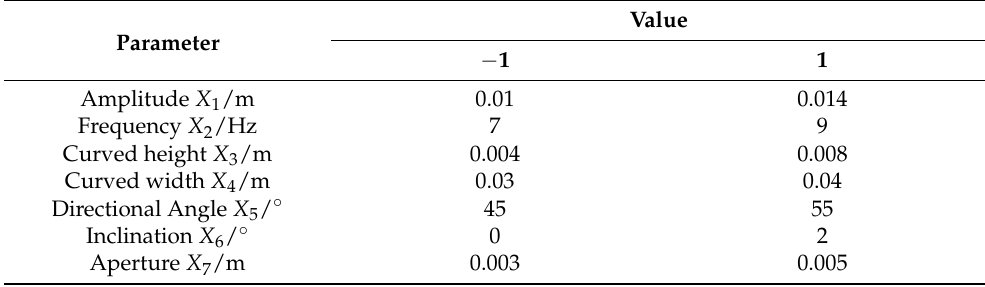
Table 3. Test parameter